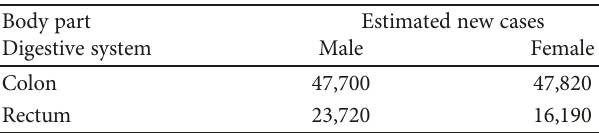
Table 1: Estimated new cases of CRC in the United States by sex in 2017 (adapted and modi fi ed from Siegel et al.